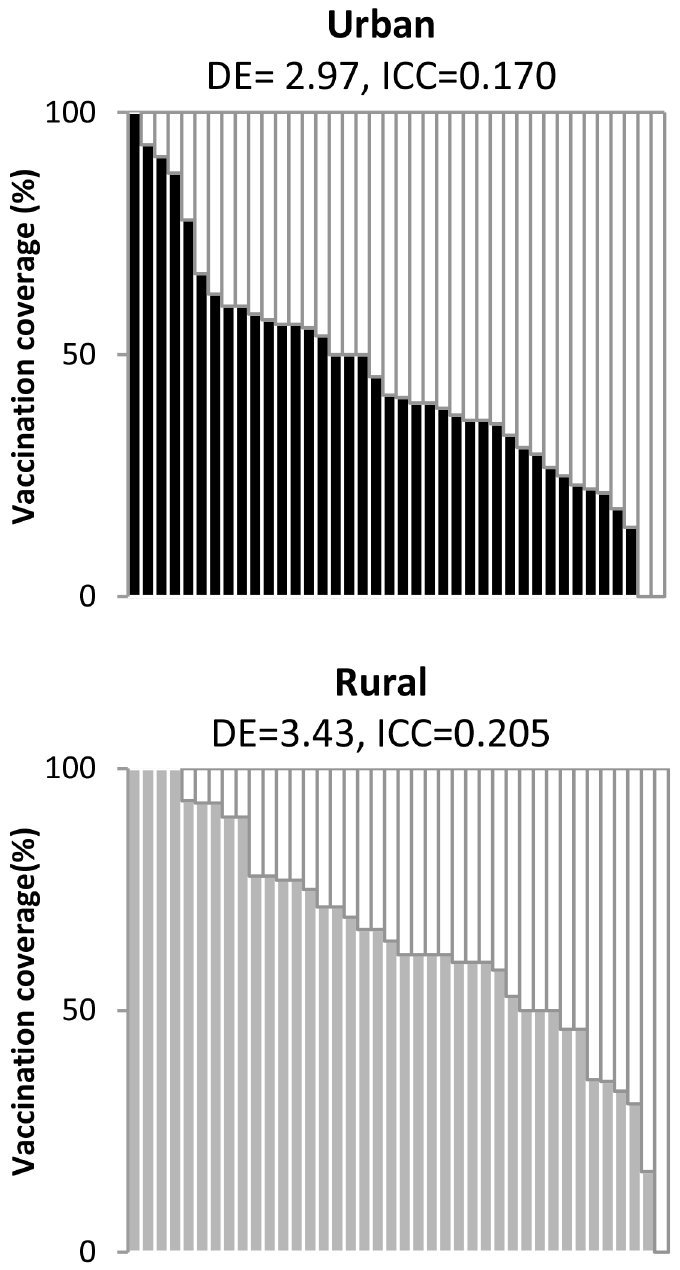
Fig 1. Cluster-level measles campaign vaccination coverage in the urban and rural surveys, Jharkhand, 2012. Organ-pipe plots of unweighted coverage by cluster were constructed for urban and rural surveys (Dale Rhoda, personal communication). Design effect (DE) and intraclass correlation coefficients (ICCs) were calculated for the respective